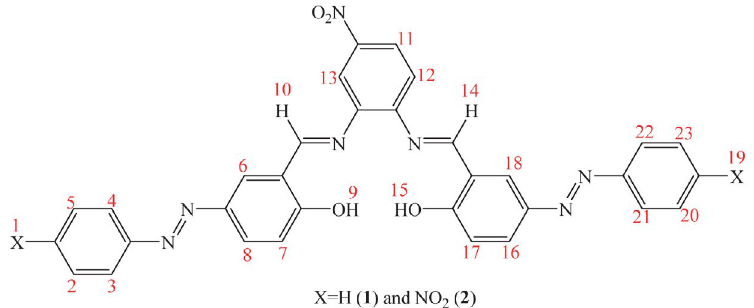
Scheme 1 : Structures of azo-azomethine